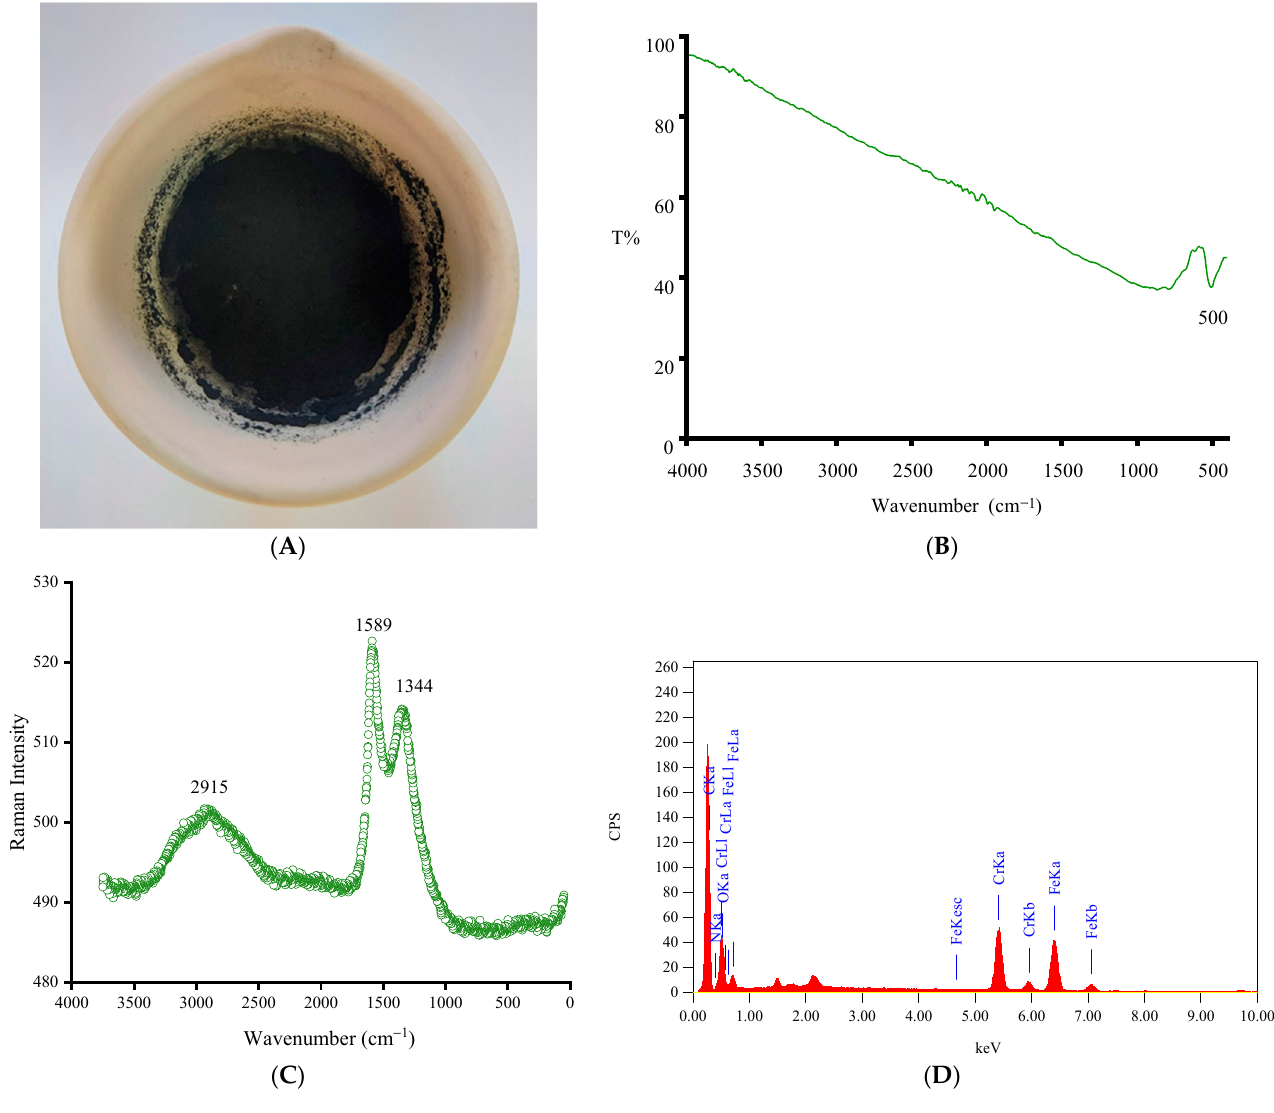
Figure 5. Characterizations of the fabricated adsorbent material: ( A ); color and shape, ( B ); IR spectrum, ( C ); Raman spectrum, and ( D ); EDX pro fi le.